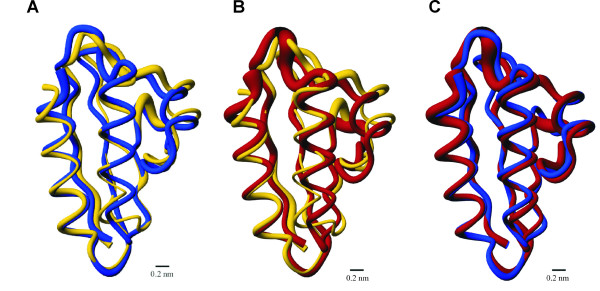
Comparison of the model structure of HPr from E. coli with the corresponding X-ray and NMR structures. A comparison of the modeled HPr homology structure with the structures experimentally determined by NMR spectroscopy (1HDN) and X-ray crystallography (1POH). The structures are shown in the same orientation as in Fig. 1 with the radius of the backbone splines indicating the RMSD of the Cα atom positions in the respective structures. (A) Overall good agreement between the model structure (yellow) and the X-ray structure (blue) is obtained. Deviations are mainly seen in loop regions and in the orientation of helices a and b. RMSD values for the Cα atom positions of the X-ray structure 1POH have been derived from the crystallographic B-factors, fB, using the Debye-Waller equation  where isotropic displacement from the mean atom positions was assumed. (B) Comparison of the model (yellow) and the NMR structure (red). Deviations are seen in the same regions as before. (C) X-ray (blue) and NMR (red) structures superimpose well. Interestingly, deviations between them are mainly observed in regions where the two structures also diverge from the homology model.